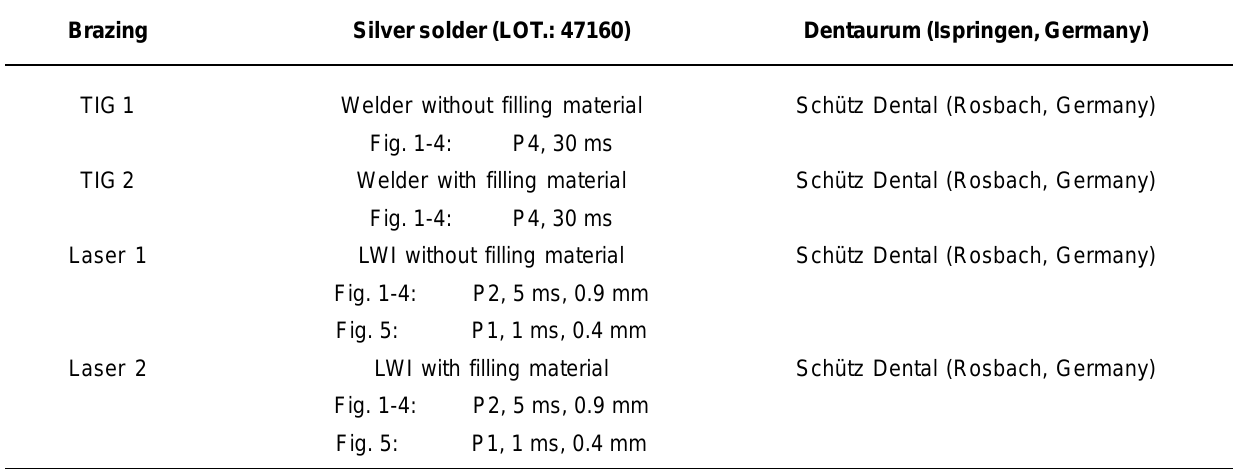
TIG=Tungsten-Inert gas welding. Laser= laser